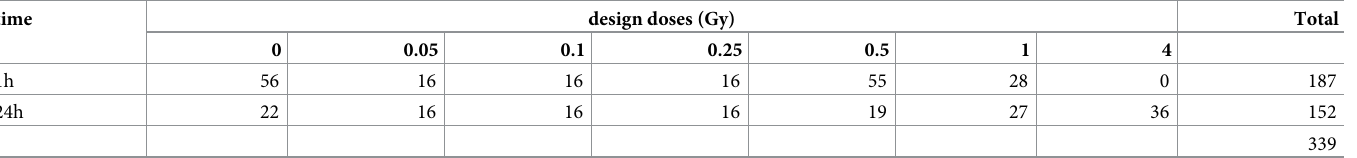
Table 1. Numbers of measurements (foci counts/cell) of the data introduced in Section 2. time design doses (Gy) Total 0 0.05